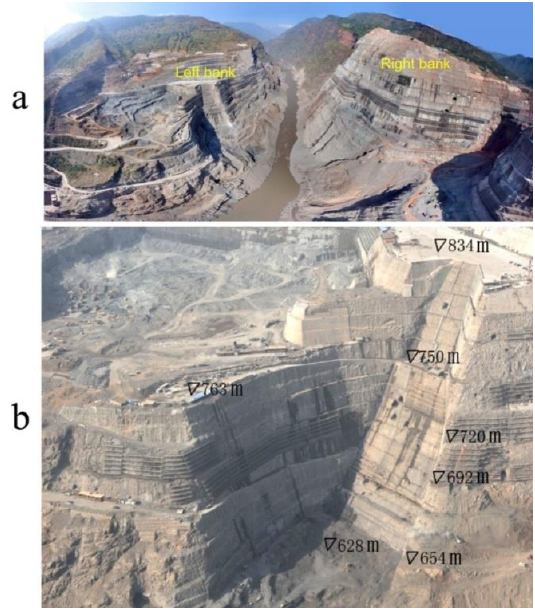
Figure 2. Photographs of the spandrel groove high slopes after excavation. ( a ) The aerial view of the rock slopes and ( b ) a partially enlarged detail of the left bank slope [26] (Copyright © 2017, Springer Nature). Table 1. Characteristics of the interlayer zones.